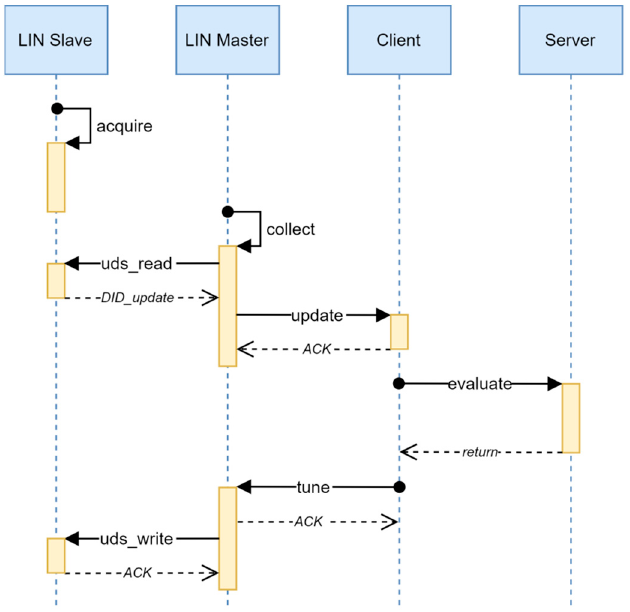
Figure 4. Diagram of distributed calibration method for LIN protocol.